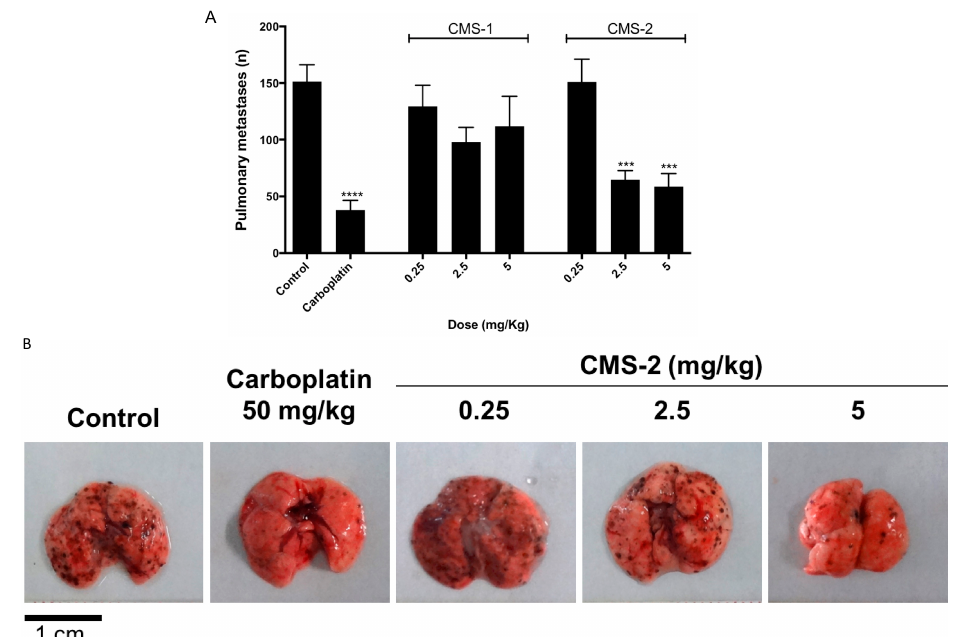
Figure 1. CMS-2 antimetastatic activity in murine melanoma B16-F10. ( A ) The number of metastatic points in lungs of C57/BL6 mice ( n = 50) after 15 days of subcutaneous treatment with saline (control), carboplatin (positive control), CMS-1 or CMS-2. *** p < 0.001 and **** p < 0.0001, analysis of variance, Mann–Whitney post-test. ( B ) Representative images of lungs from control or treated mice.